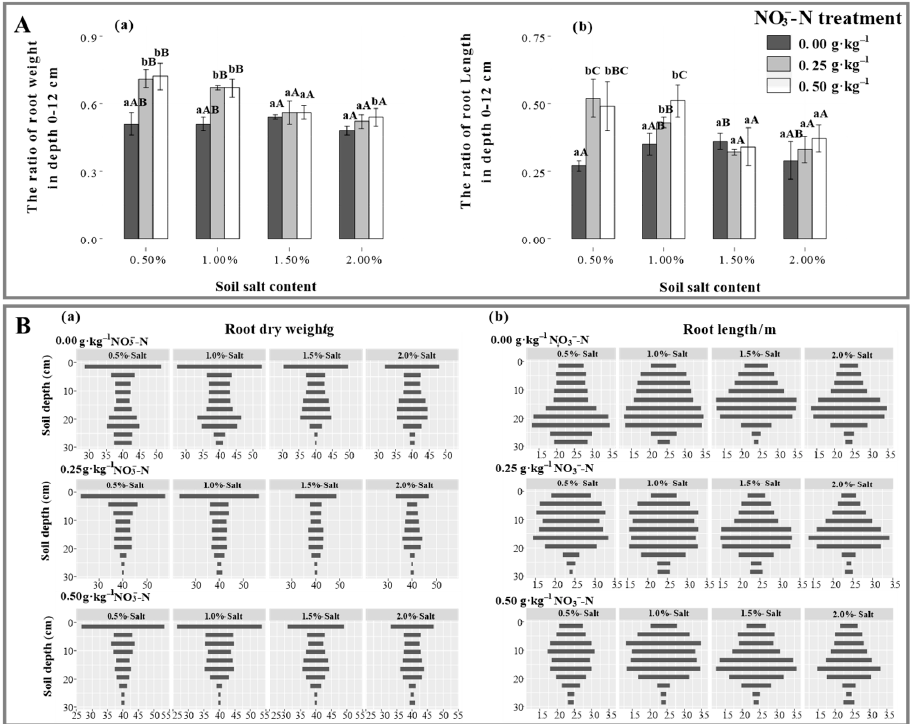
Figure 2. Effects of NO 3 (cid:2879) ‐ N treatments on the root biomass and length distribution of Suaeda salsa grown at different salt levels. A ( a , b ) represents the ratio of root weight to length in depth 0–12cm. B ( a , b ) represents the root biomass and length distribution. Capital letters indicate significant differences among the four salt levels. Lowercase letters indicate significant differences among the three NO 3 (cid:2879) N treatments.